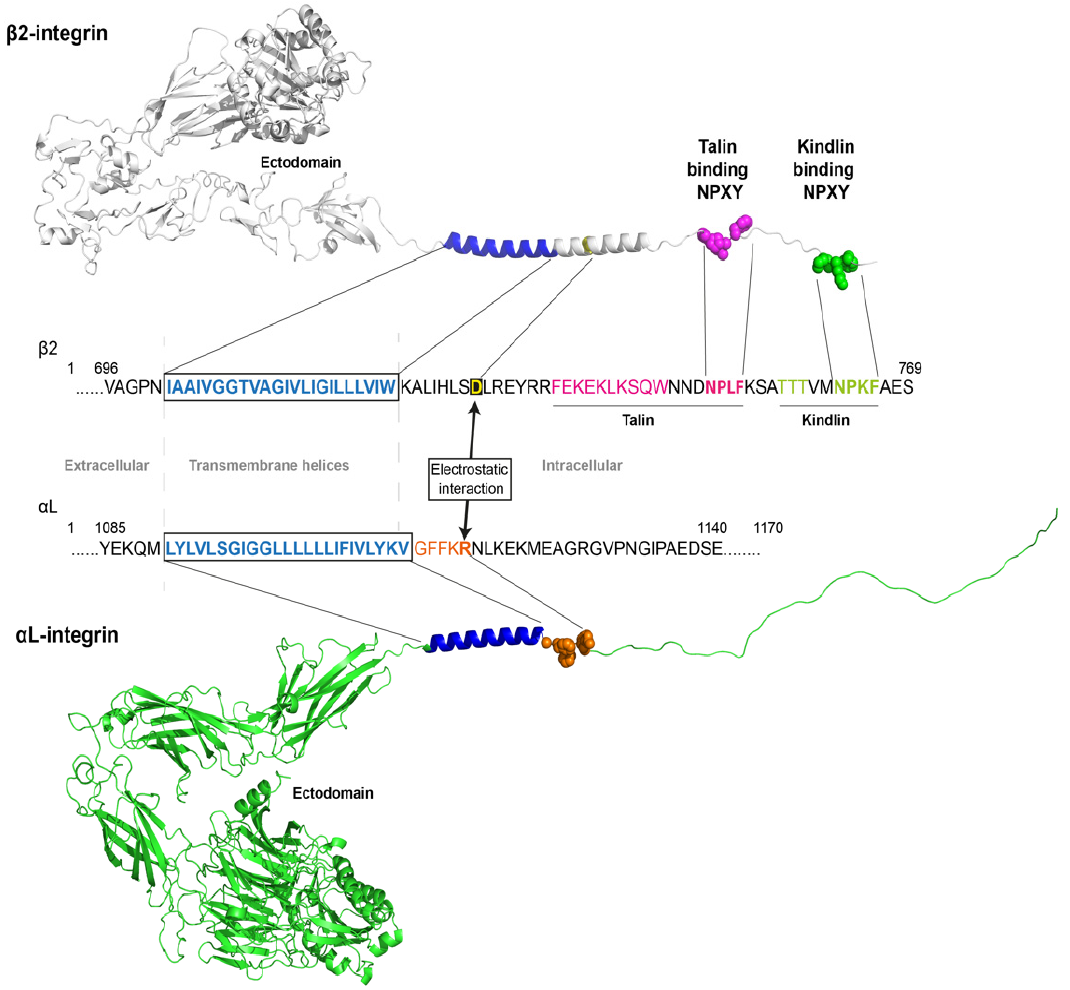
Figure 4. Integrin structure and binding sites for talin and kindlin. The integrin α L β 2 consists of an ectodomain followed by transmembrane helices and intracellular domains, respectively. Talin-1 and kindlin-3 bind to distinct binding sites (NPLF, membrane-proximal and NPKF, membrane-distal) on the β 2 subunit, respectively. The inhibitory salt bridge (electrostatic interaction) of the intermem- brane clasp is formed between the α L-arginine in the highlighted GFFKR sequence (red) and β 2- aspartic acid (boxed in black).